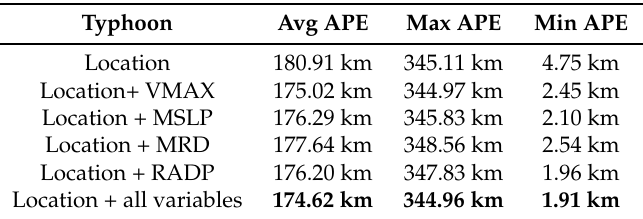
Table 8. Avg APE, max APE, and min APE of different